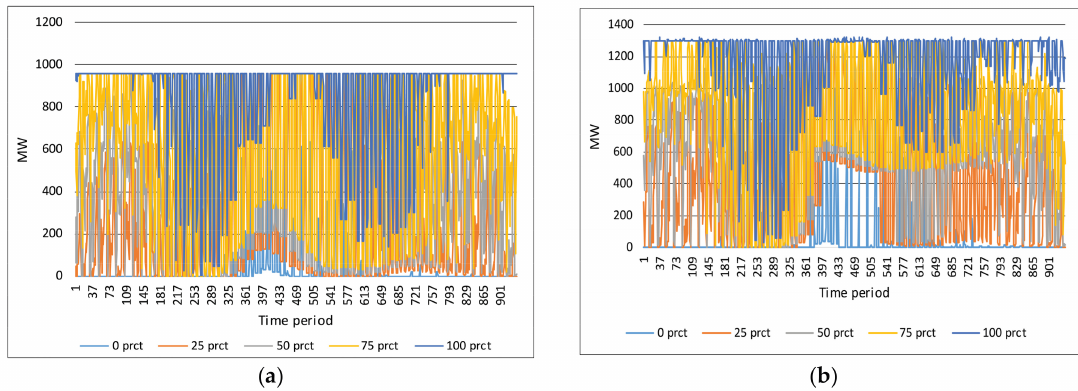
Figure 10. Percentiles (0, 25, 50, 75, 100) for production for Tonstad time step-by-time step over the year: ( a ) Present capacity 1.0 GW; ( b ) 1.1 GW extra capacity (11 GW extra in